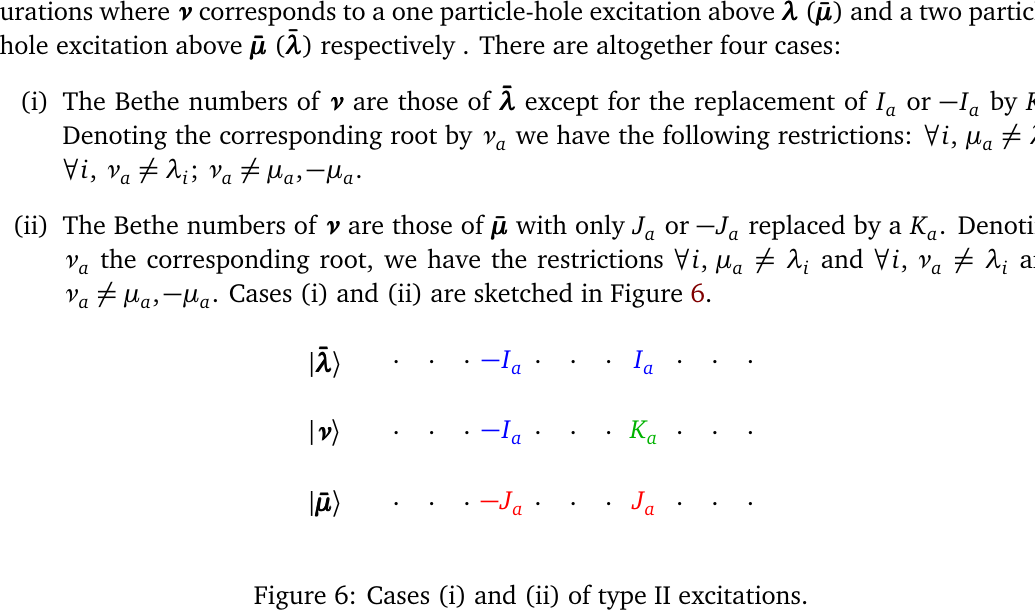
Figure 6: Cases (i) and (ii) of type II excitations.